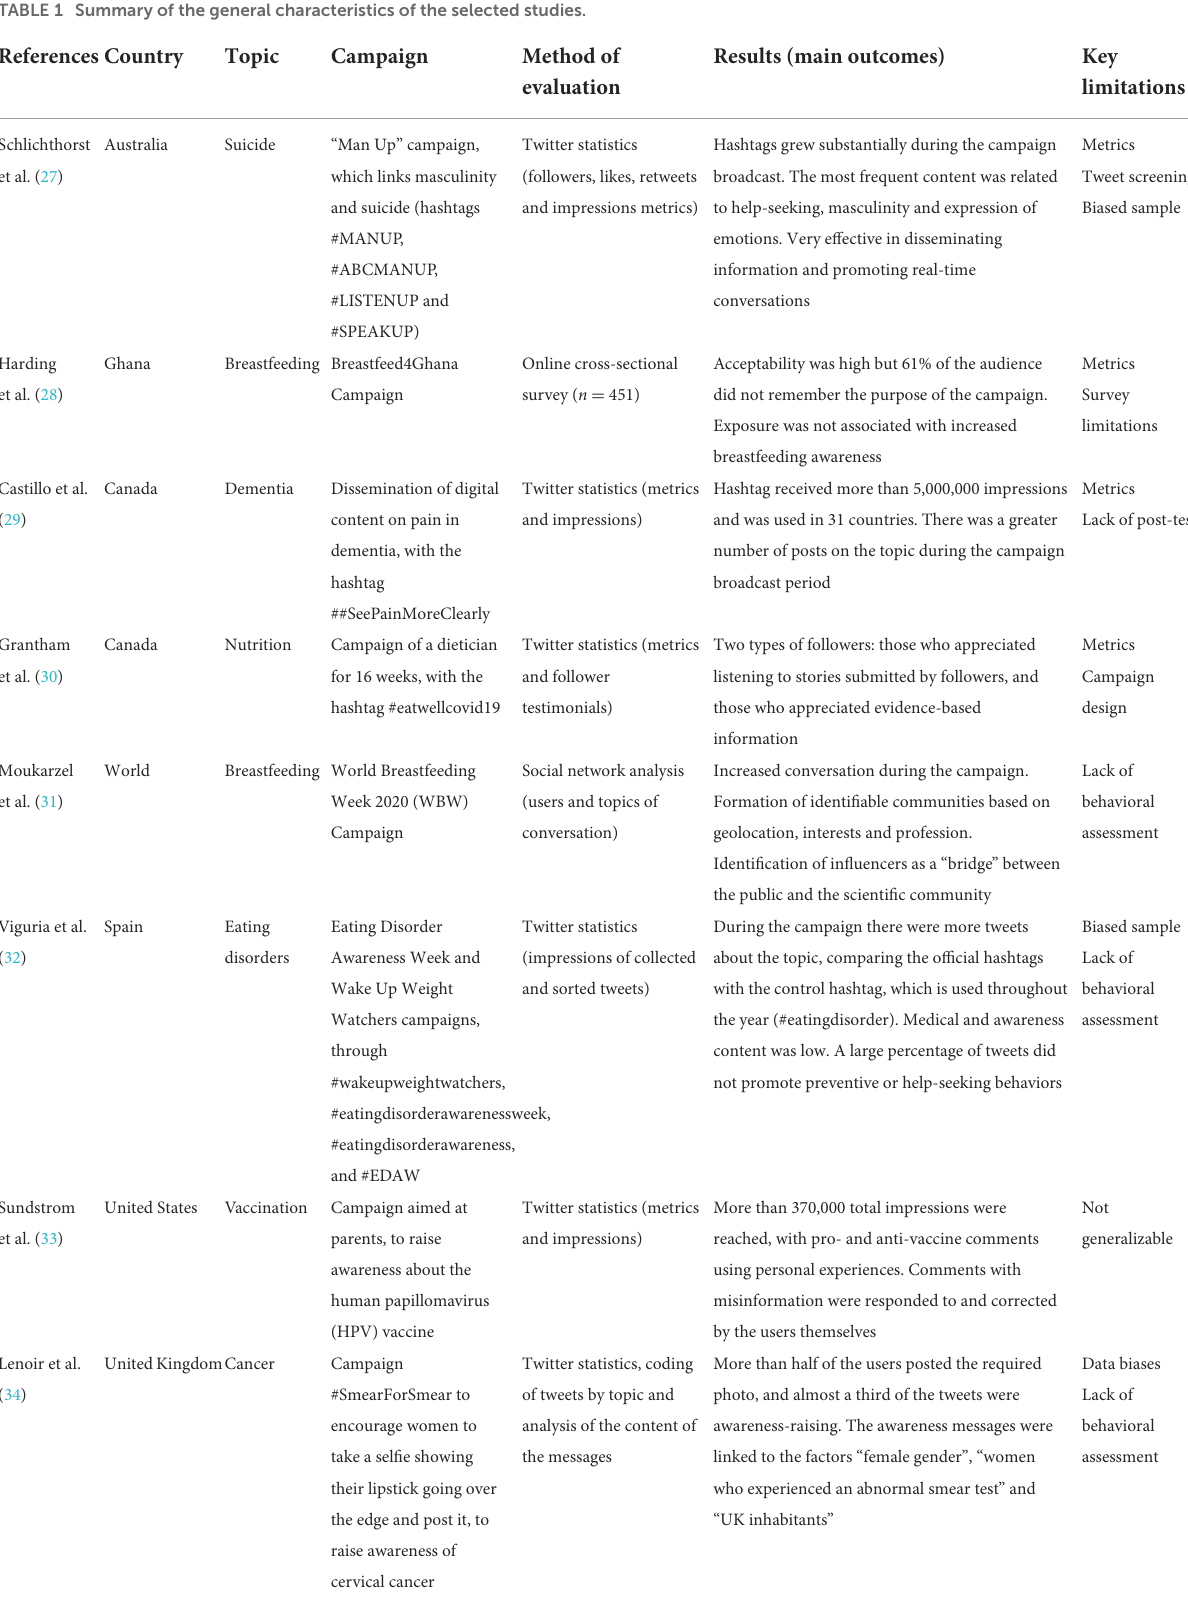
TABLE 1 Summary of the general characteristics of the selected